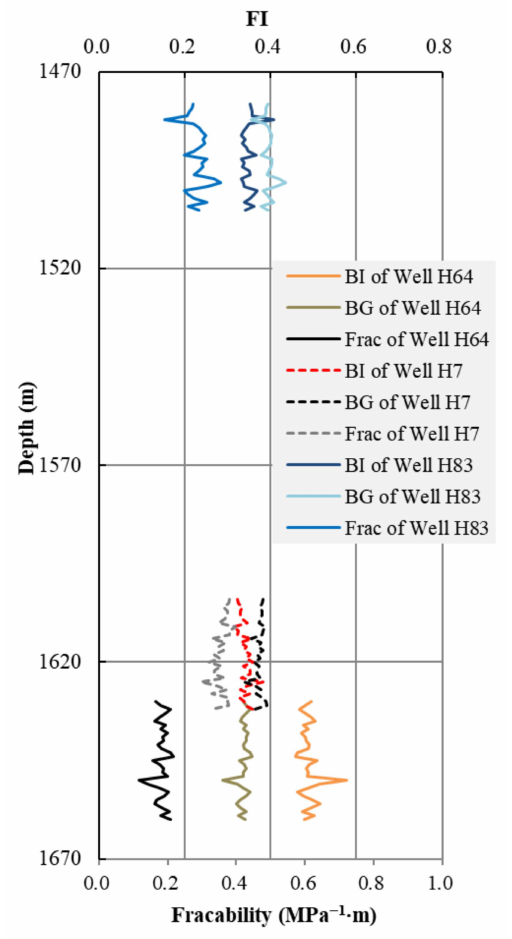
Figure 9. The fracability results of fractured sections from the three wells were compiled separately for better